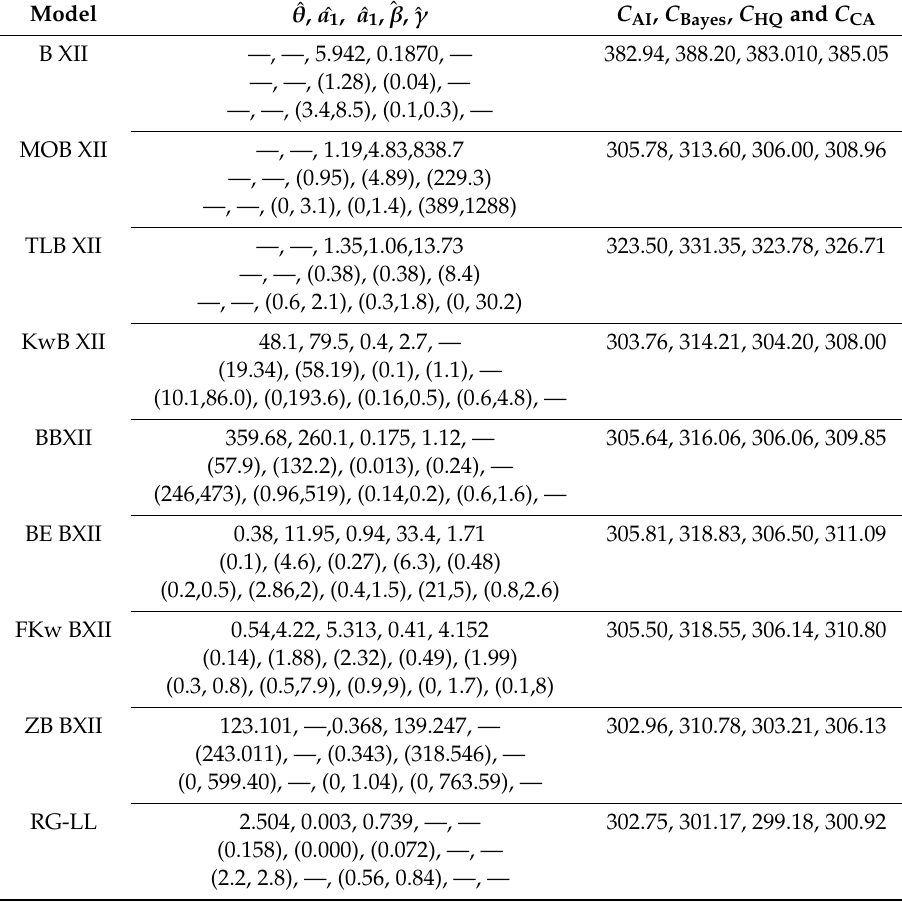
Table A3. MLEs, SEs and CIs with C AI , C Bayes , C HQ and C CA for the breaking stress of carbon fibers data.